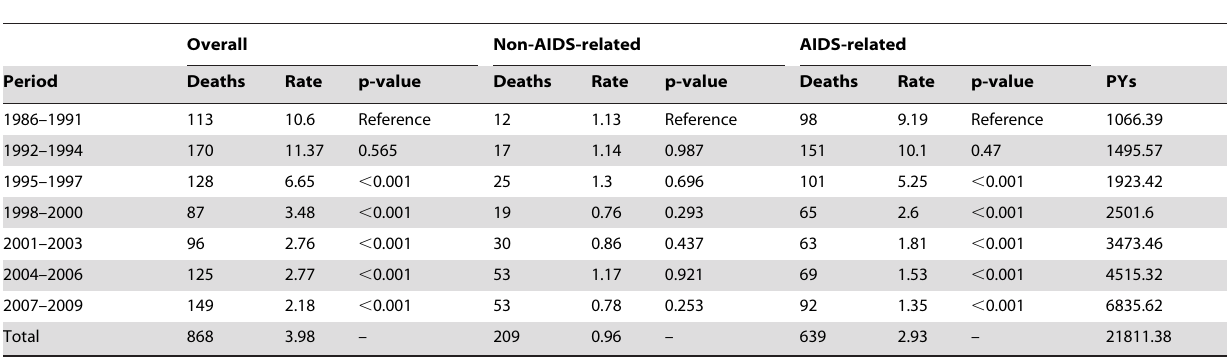
Table 3. Mortality rates overall, and for AIDS-related and non-AIDS related causes of death over calendar periods.